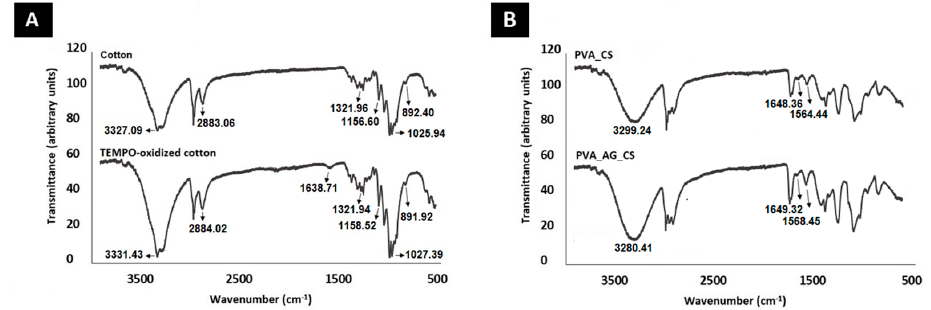
Figure 3. Attenuated total reflection-Fourier transform infrared (ATR-FTIR) analysis of the produced dual-layer dressing materials. Cotton layer ( A ), and the nanofibrous coating layers ( B ).